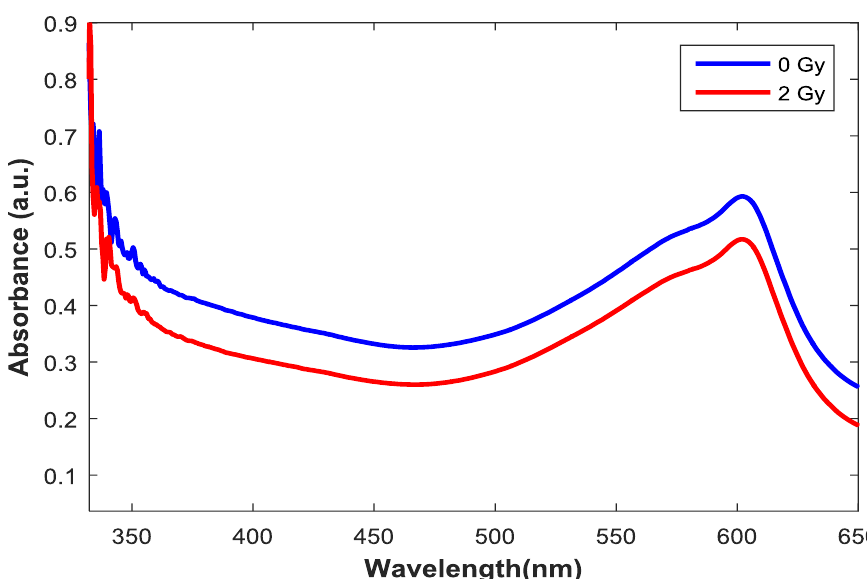
Fig. 6. Absorption-wavelength curve of GENIPIN gel in the presence of 0.1 mM of spherical bismuth oxide nanoparticles